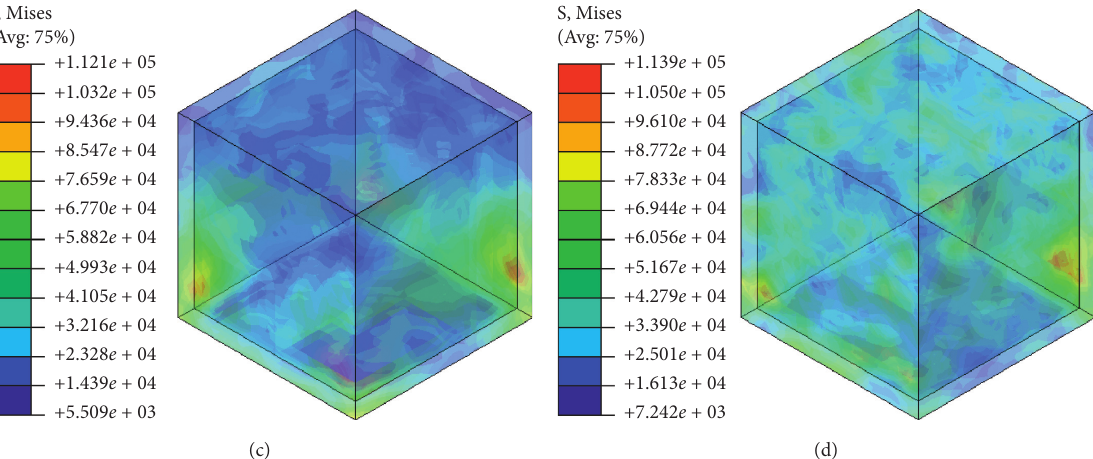
Figure 5: Comparison of the von Mises stress on the walls between the two algorithms. (a) At 0.8 s with the SPH-FEM algorithm, (b) at 0.8s with the CEL method, (c) at 1.6s with the SPH-FEM algorithm, and (d) at 1.6s with the CEL method.